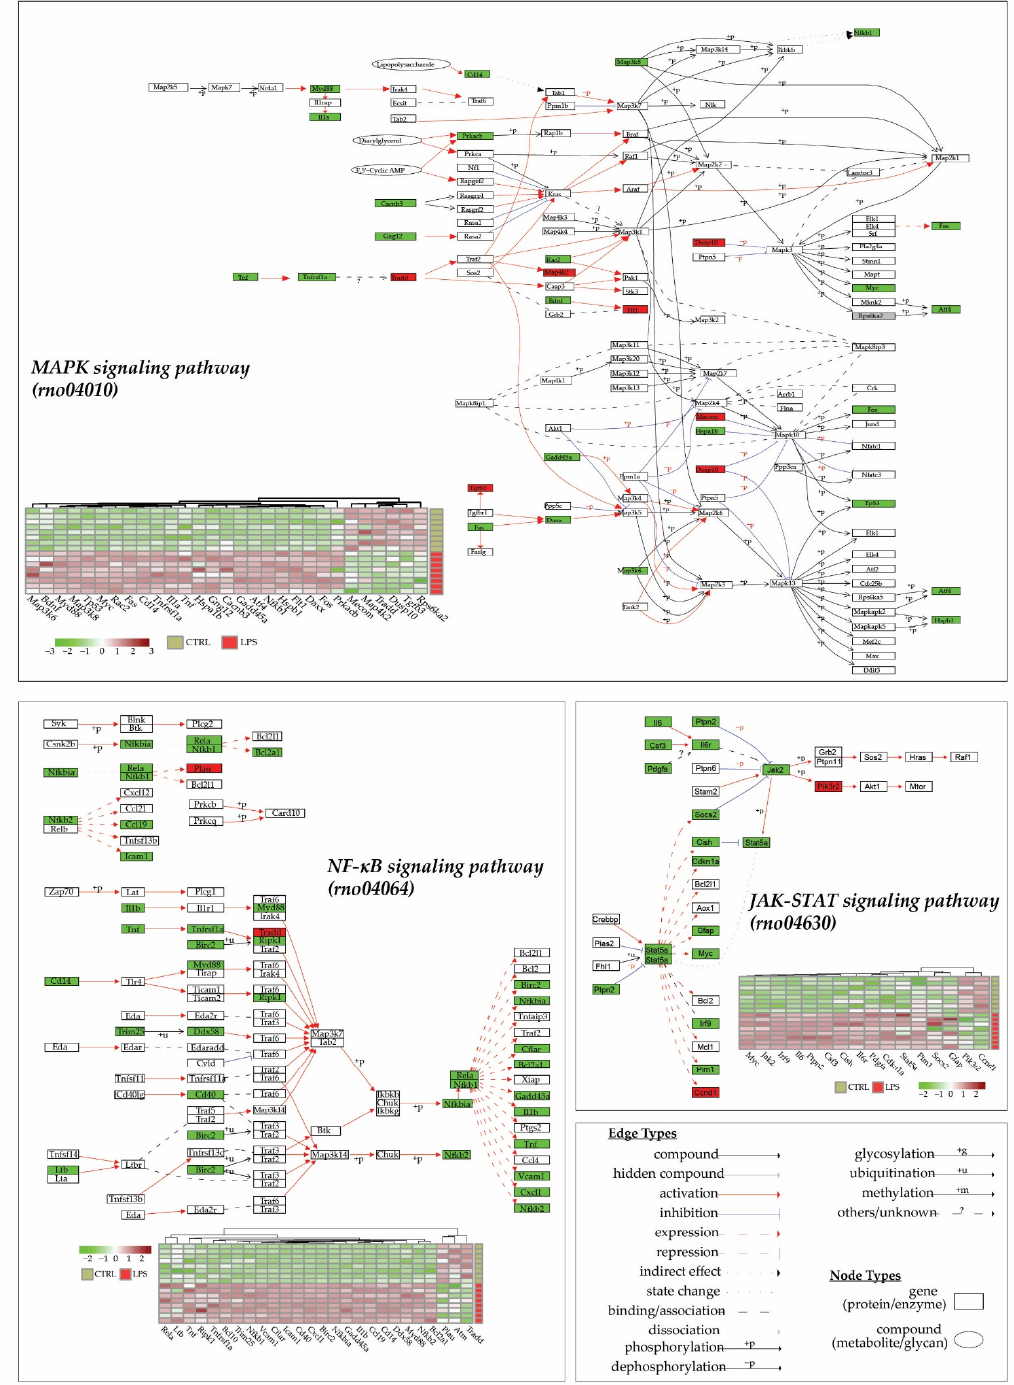
Figure 4. LPS injection promotes cytokine and inflammatory pathways. Transcriptome analyses were made from whole heart of rats injected with LPS (LPS) or saline (CTRL), and this allowed the identification of 13730 genes. Differentially expressed genes (DEGs) were selected by their fold change of expression (log2Ratio(LPS/CTRL) >1 or (log2Ratio(LPS/CTRL) > − 1 and an adjusted p value < 0.05 using the R package “Deseq2”. KEGG (Kyoto Encyclopedia of Genes and Genomes) enrichments were conducted to decipher most impacted pathways. Represented here are 4 main pathways in the heart that were impacted by LPS injection in CTRL rats: the MAPK signaling pathway (rno04010), the JAK-STAT signaling pathway (rno04630), and the NF- κ B signaling pathway (rno04064). Each DEGs expression in pathways is represented in a